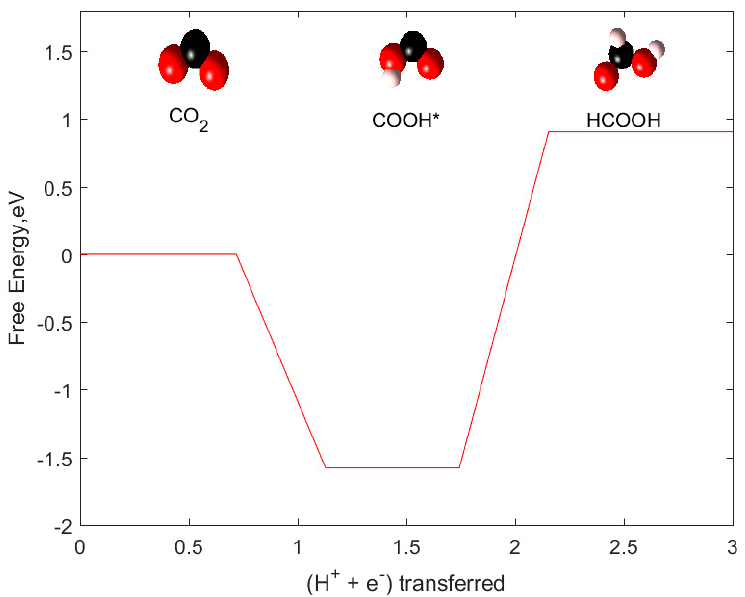
Figure 1. Lowest energy pathway of CO 2 reduction to HCOOH at U = 0 V on WC/graphene. Color code of atoms: red: oxygen, black: carbon, white: hydrogen.